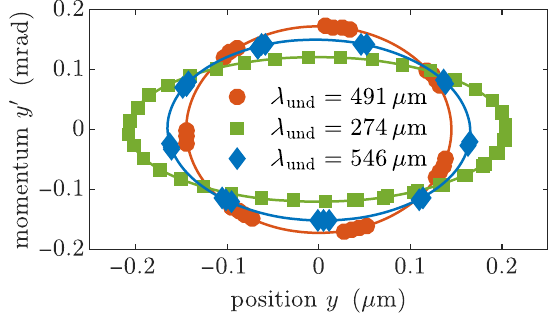
FIG. 12. Poincar´e plots for the three synchronous DLA undulator lattices based on the phase space coordinates ð y; y 0 Þ 25 pm single-particle emittance evaluated of particles with ε y ¼ after each FODO period λ und